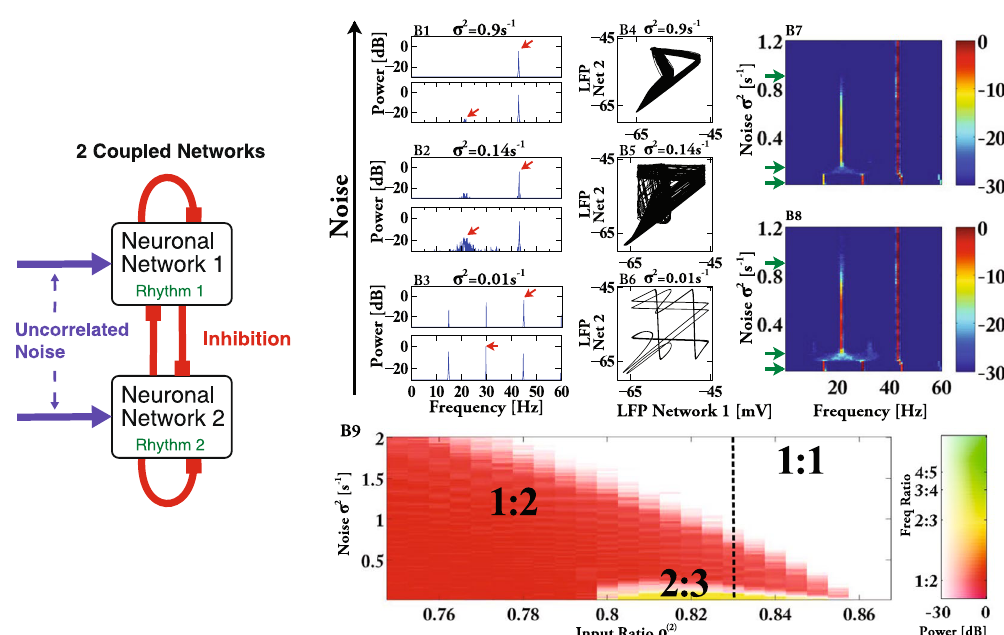
Figure 2. Increasing the uncorrelated noise in the inputs to the individual neurons synchronizes the population rhythms of interconnected networks of IF-neurons. ( A ) Temporal evolution of the phases φ ( α ) ( t ) of the population rhythms α V t ( ) ( ) of the  = 100 networks. ( A1 ) For weak noise ( σ 2 = 0.04 s − 1 ) the rhythms are not synchronized; shown is φ ( α ) ( t ) for α = … 4, 8, 12, 100 . ( A2 ) Strong noise ( σ 2 = 2 s − 1 ) synchronizes the rhythms. ( B ) The time-averaged order parameter r global of the interconnected networks (lower panel) increases hysteretically with increasing strength of the uncorrelated noise (error bars denote standard deviation). The order parameters r ( α ) of the individual networks (upper panel) decrease with noise, time-averaged r (1) and r (100) are shown. Parameters: γ 0 = 0.0065, g syn = 0.021, μ = 200 s − 1 , τ = 20 ms, τ 1 = 4 ms, τ 2 = 5 ms, τ d = 2 ms, V rest = − 55 mV, V θ = − 45 mV, V r = − 65 mV, V rev = − 85 mV, . The parameters γ 0 and g syn have been scaled so that the overall conductances of the connections within and across the networks correspond to those in the 2-network case discussed below (Fig. 3).